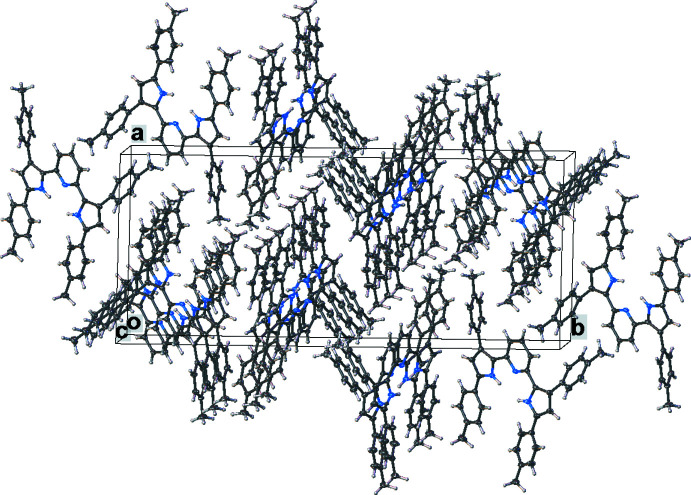
The crystal packing of [pyrr2Py]H2.